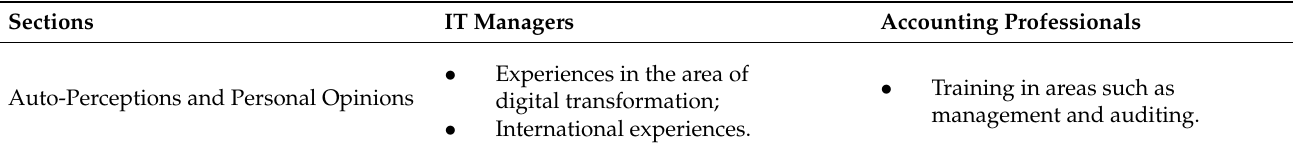
Table 6. Topics noted by the